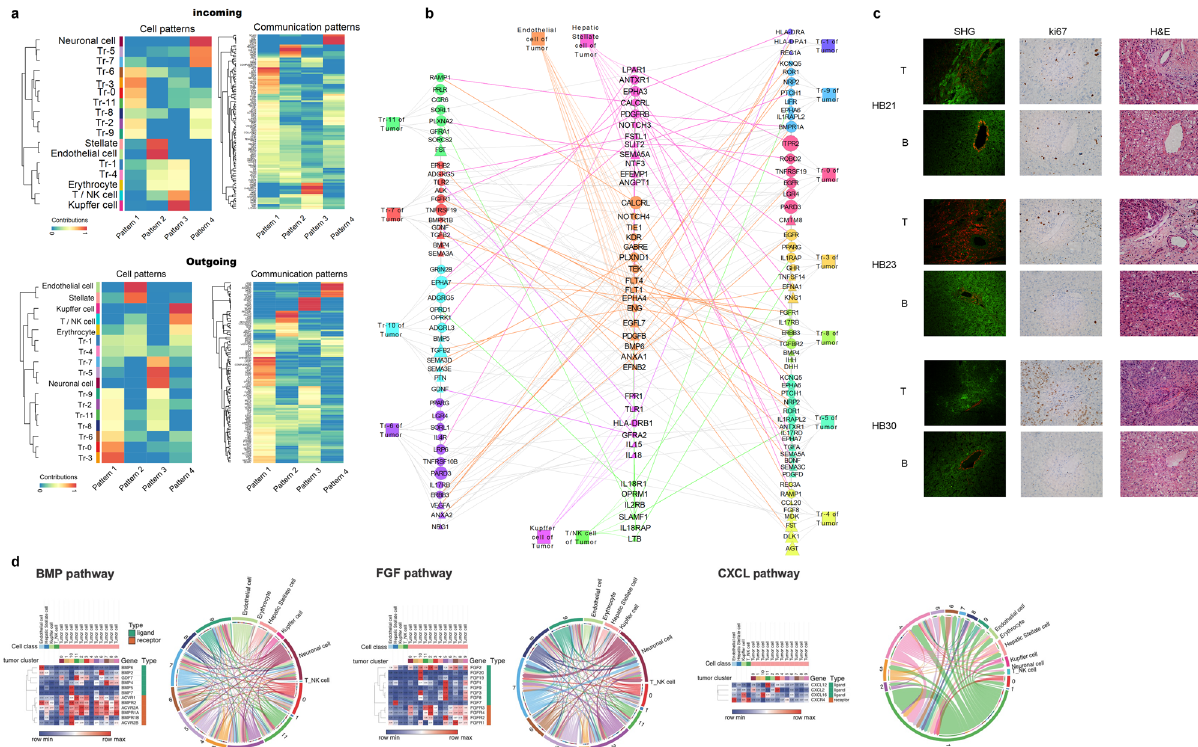
Fig. 7 Differential signaling between tumor cell clusters and microenvironment cells. a Signaling pathways were predicted using CellChat to show interaction patterns between tumor subclusters and microenvironment cells. Four main patterns of ingoing and outgoing signals were identi fi ed, and associated pathways shown. b A network of signaling interactions of upregulated genes between tumor cell clusters and supporting tumor microenvironment cells shows crosstalk between cells in tumor. Gene – gene interactions were inferred using ToppCluster and interaction pairs between tumor cells and microenvironment cells were highlighted. Node size represents normalized expression levels of genes in each cell type. Node shape represents ligands (triangle) and receptors (circle). c Second harmonic generation (SHG) microscopy of tumor and background liver. Left to right, SHG (red — SHG, green — auto fl uorescence), KI67, and H&E staining demonstrates disorganized vessel structure in tumor samples. 20X Plan APO, 1024 × 1024 resolution, scale bar 50 µ M. d Heatmaps and CellChat chord diagrams of upregulated pathways with indicated receptor/ligand interactions are highlighted. Extensive BMP , FGF , and CXCL signaling networks are shown. Lowly expressed genes in each pathway (maximal row values less than 0.5) were removed from the